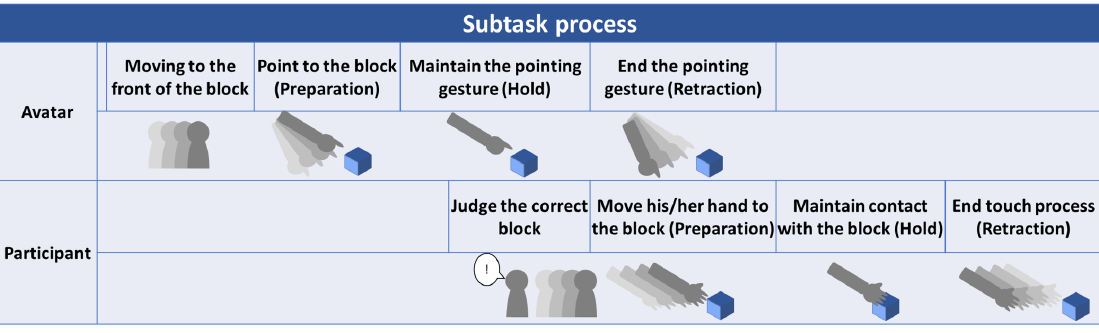
Figure 3. Gesture phase of a